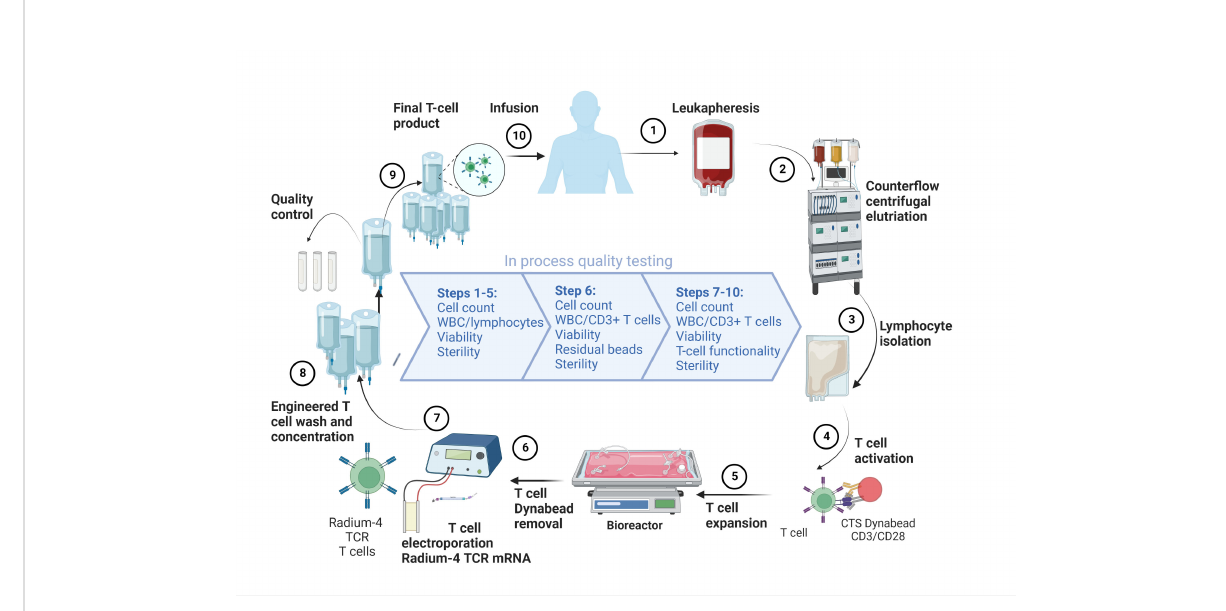
FIGURE 1 Overview of the GMP-production platform for TCR T cell therapy. Created using